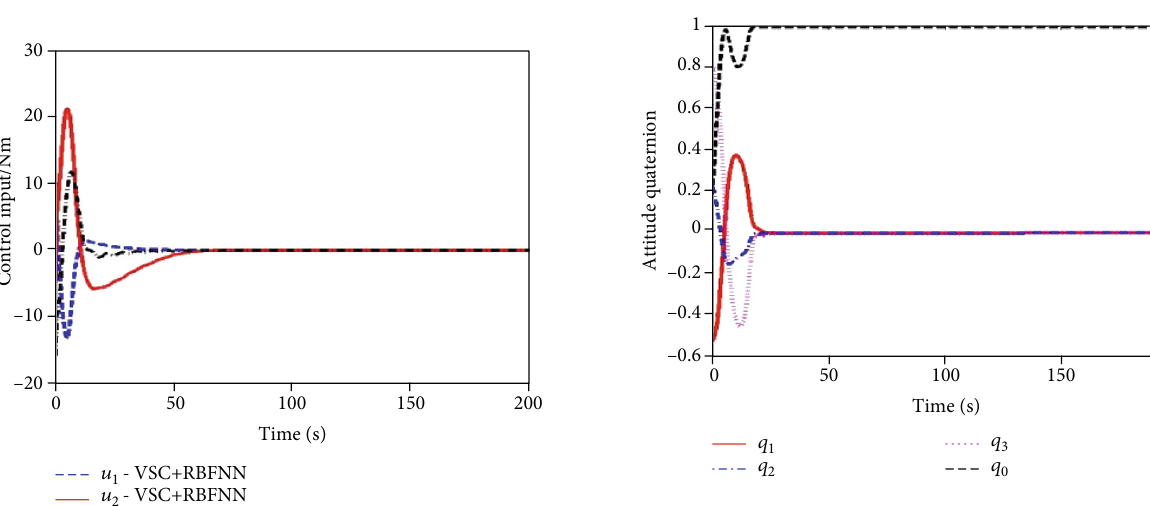
Figure 7: Time histories of estimated NN optimal weight in Case